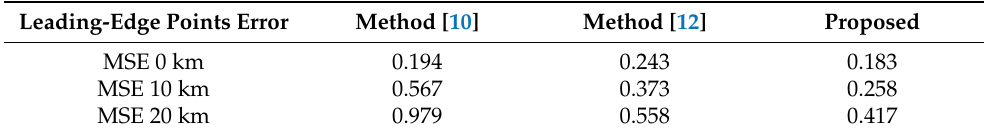
Table 2. Comparison of average critical frequency errors (MHz).